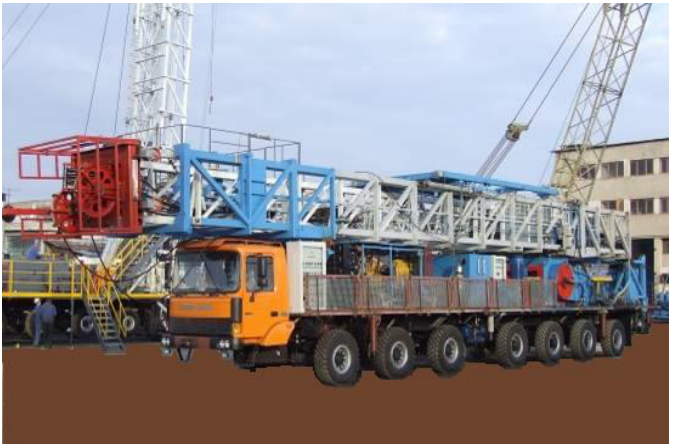
Figure 1. Special vehicle for oil exploitation.